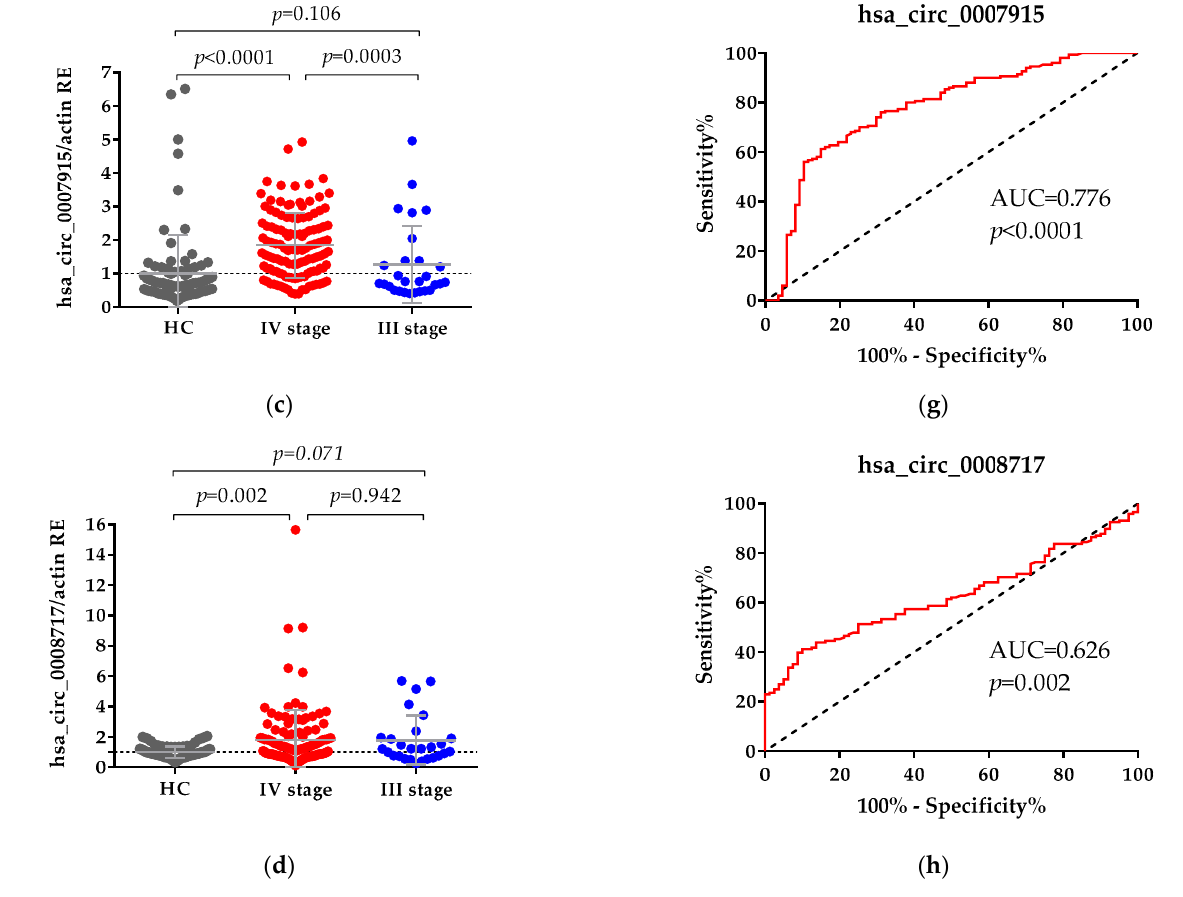
Figure 1. Relative expression (RE) of circRNAs: ( a ) comparison between levels of hsa_circ_0001445, ( b ) hsa_circ_0003028, ( c ) hsa_circ_0007915 and ( d ) hsa_circ_0008717 in plasma samples from healthy controls (HC) and patients with CRC in stages III and IV. The expression levels of all circRNAs were measured using qPCR. β -actin RNA was used as an internal control. Relative gene expression level was calculated using the 2 −∆∆ C t method. The Mann–Whitney U test was used to compare HC and CRC patients; data are presented as mean ±SD. ROC curves of ( e ) hsa_circ_0001445, ( f ) hsa_circ_0003028, ( g ) hsa_circ_0007915 and ( h ) hsa_circ_0008717 differentiate patients with CRC from HC.